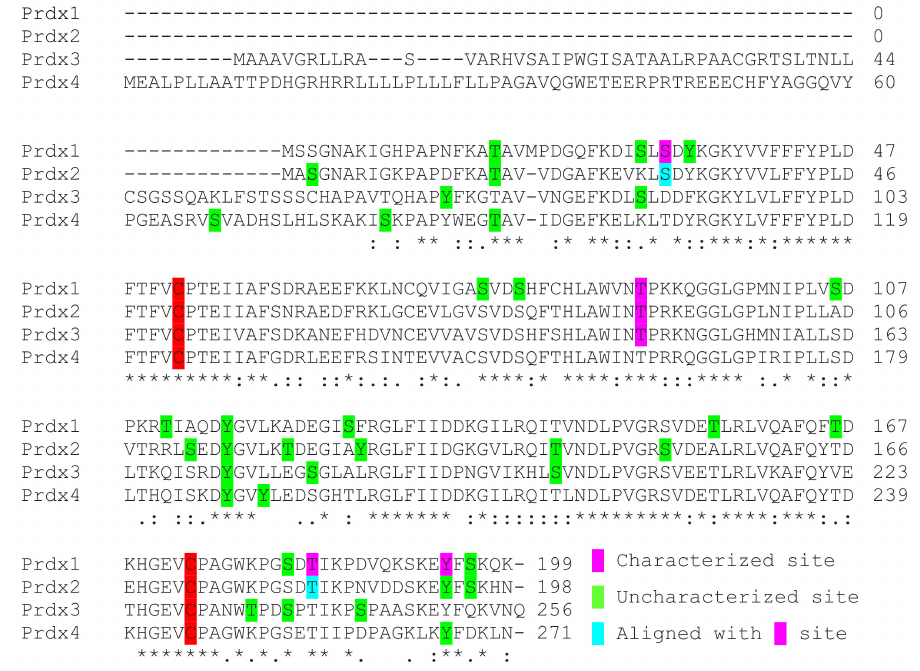
Figure 4. 2-Cys Prdx alignment of observed phosphorylation sites. Alignment of the 2-Cys Prdx family members. Phosphorylation sites that have been characterized are highlighted in pink, uncharacterized sites that have been identified in proteomic studies are highlighted in green and sites that are aligned with characterized phosphorylation sites are highlighted in